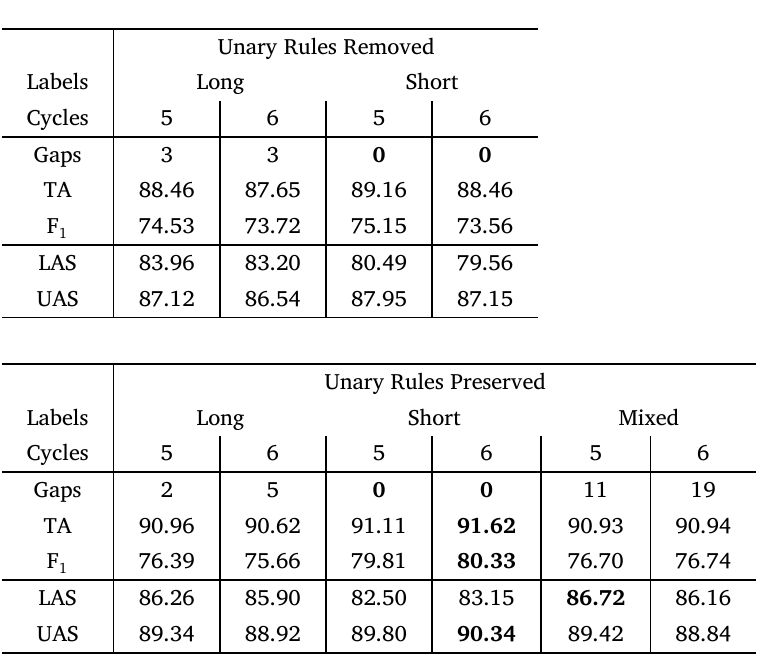
Table 3: Tagging accuracy, parseval F 1 , and dependency accuracy for Berkeley on WSJ development